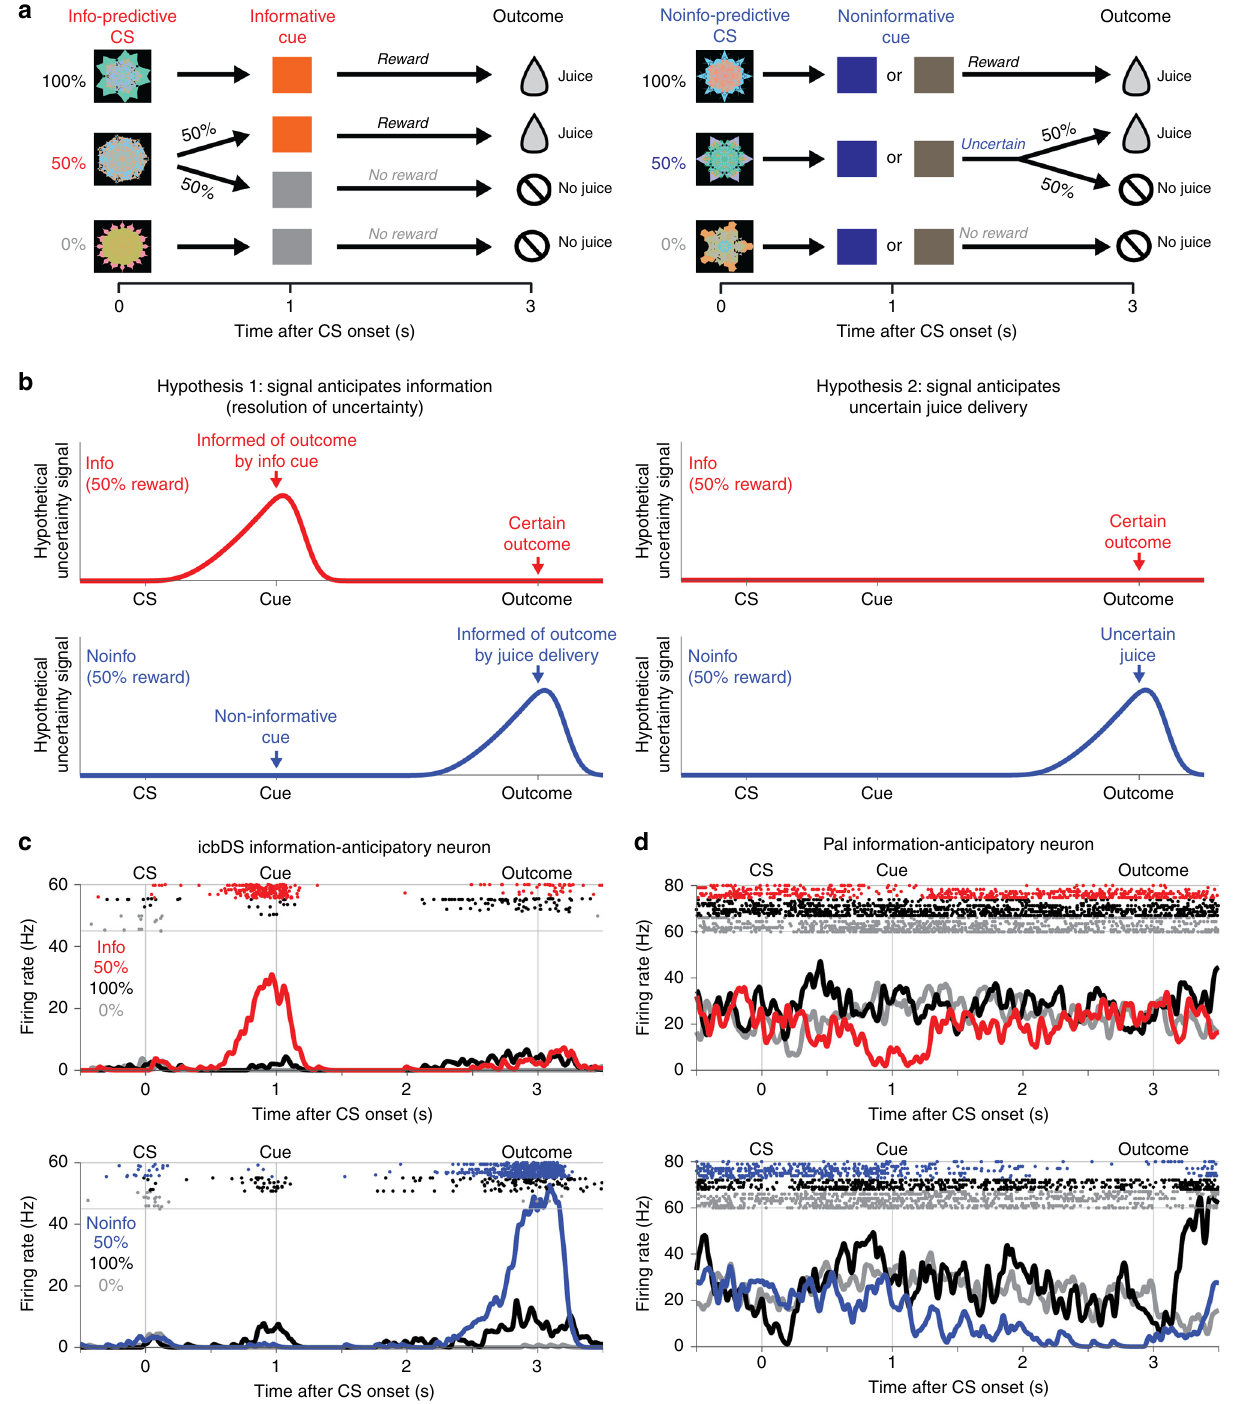
Fig. 2 Neuronal activity anticipating the moment of gaining information to resolve reward uncertainty. a Information task. On Info CS trials, CSs predict 100, 50, or 0% reward, and are followed by an informative cue that indicates the outcome with certainty. On Noinfo CS trials, analogous CSs are followed by one of two noninformative cues that are randomized, and hence leave the outcome uncertain until it is delivered at the end of the trial. b Testing two hypotheses about the origin of uncertainty-related activity. In Hypothesis 1 (left), activity on 50% reward trials anticipates the moment of gaining information about the uncertain outcome, and hence anticipates both informative cues (top, red, Info CS) and uncertain outcomes (bottom, blue, Noinfo CS). In Hypothesis 2 (right), activity simply anticipates uncertain outcome delivery, and hence has no differential activity during the CS period because it only anticipates uncertain outcomes (bottom, blue, Noinfo CS). c An icbDS neuron with information-anticipatory activity. This neuron has strong ramping activation on 50% reward trials that anticipates informative cues (top, red, Info CS) and uncertain outcomes (bottom, blue, Noinfo CS). Its activity is greatly reduced or absent when the outcome is certain (100% reward, black; 0% reward, gray). d An example Pal neuron with information-anticipatory activity. This neuron has a similar response pattern but with ramping inhibition rather than